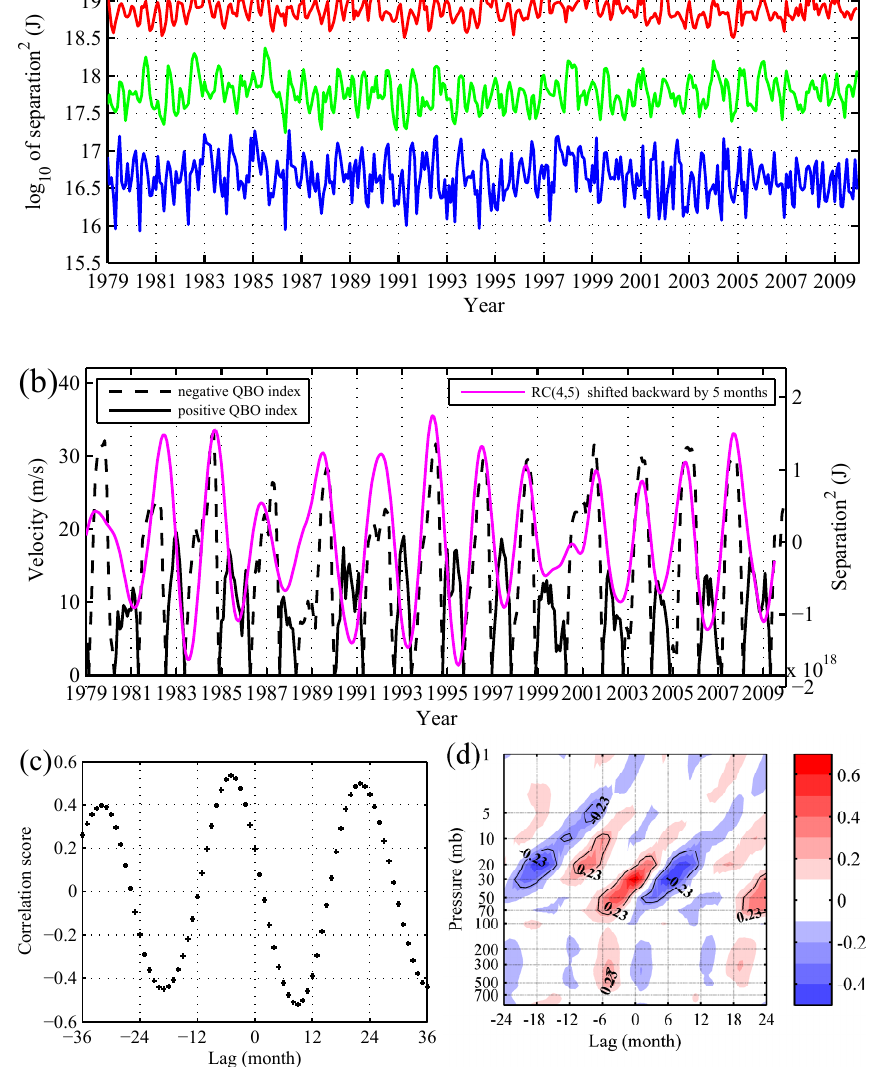
Figure 8. (a) Kinetic (red), enthalpy (green) and surface pressure (blue) components of separation-squared between CFSR monthly mean data and its annual mean climatology in the equatorial tropics (5 ◦ S–5 ◦ N) integrated over the whole atmosphere column. (b) (cid:107) QBO index (cid:107) (black) and RC(4, 5) of kinetic separation-squared (magenta) shifted backward by 5 months. Black solid (dashed) lines represent westerly (easterly) phase of the QBO. (c) Lag correlation of (cid:107) QBO index (cid:107) with the RC(4, 5) of kinetic separation-squared. (d) Lag correlation of (cid:107) QBO index (cid:107) with kinetic separation-squared at different pressure levels. The black contours denote the 99%-confidence level. In (c, d) , a positive lag denotes the signal leading the QBO